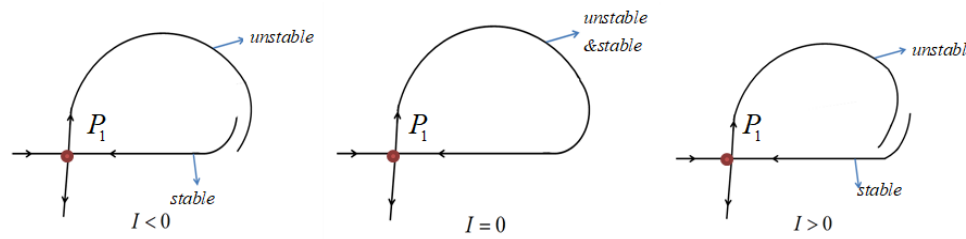
Figure 3. The homoclinic orbit local properties.